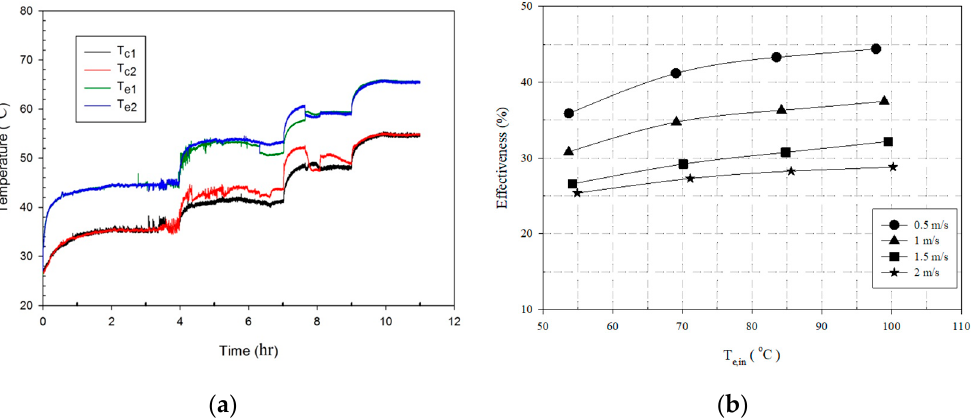
Figure 9. For water-charged PHP heat exchanger with filling ratio of 50% at airflow velocity ranging from 0.5 to 2.0 m/s, the ( a ) variation of surface temperature in both evaporating and condensing sections with time at hot air inlet temperatures stepwise increased from 55 to 100 °C, and ( b ) effectiveness versus the evaporator temperature.